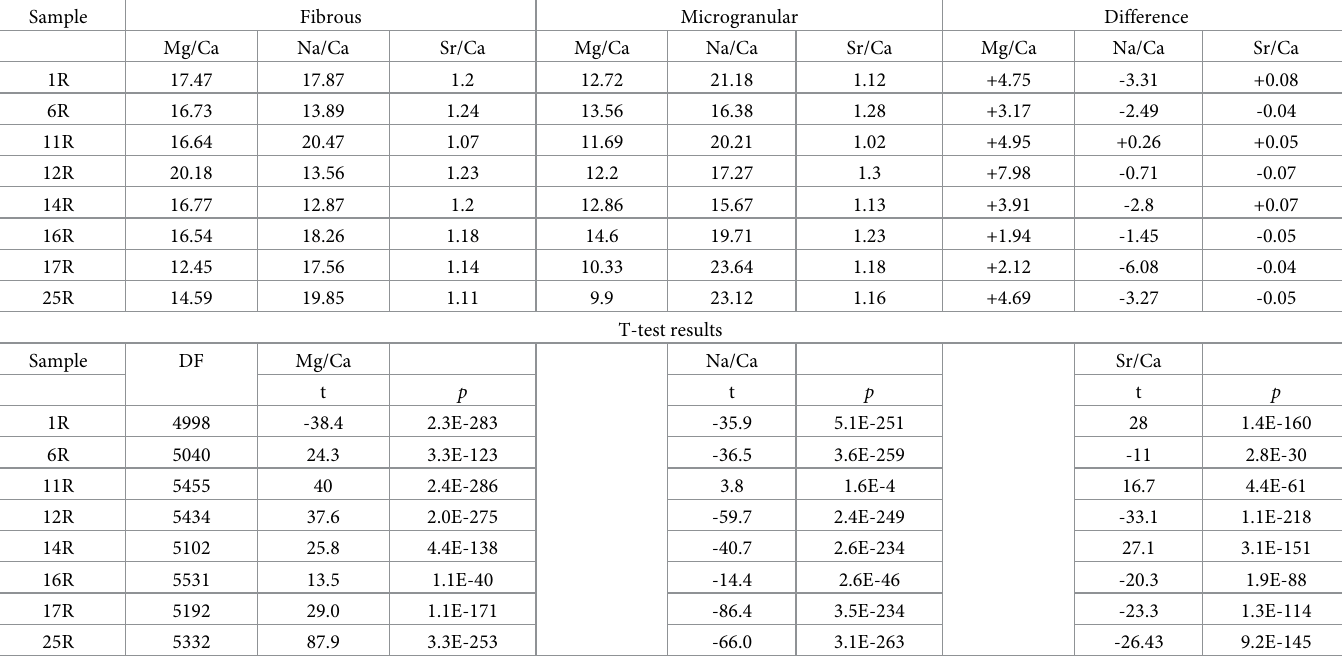
Table 3. Mean E/Ca ratios (mmol/mol) and differences between the fibrous and microgranular shell layer.